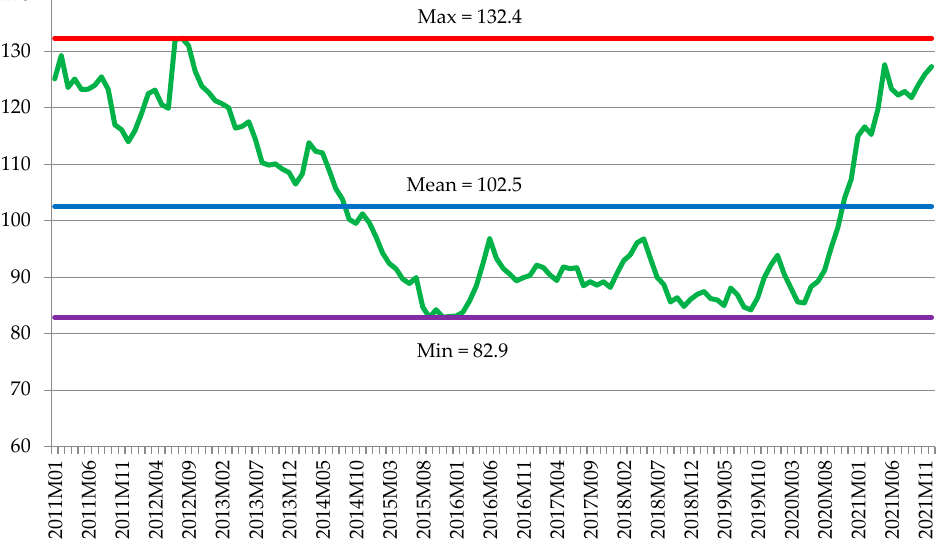
Figure 3. Monthly indices of world food prices (based on nominal US dollars, 2010 = 100) and their variability in 2011–2021.